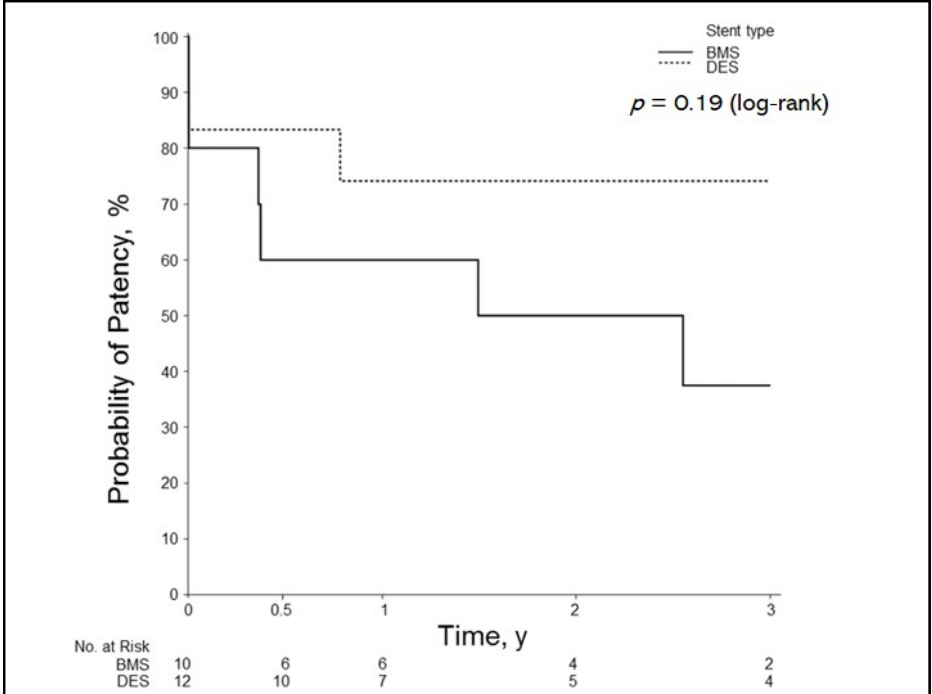
Figure 1. Patency outcomes by stent type for all arteries. Results of Kaplan–Meier analysis show primary patency of DES vs. BMS in hepatic artery stenosis. BMS indicates bare-metal stent; DES, drug-eluting stent. y, year(s).